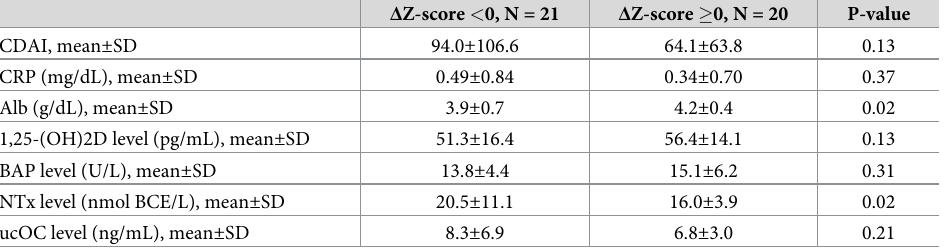
CDAI, Crohn Disease Activity Index; SD, standard deviation; CRP, C-reactive protein; Alb, albumin; BAP, bone- specific alkaline phosphatase; NTx, N-terminal telopeptide of type I collagen; ucOC, undercarboxylated osteocalcin; 1,25-(OH)2D, 1,25-dihydroxyvitamin D. Certain data represent the mean ± standard error of mean